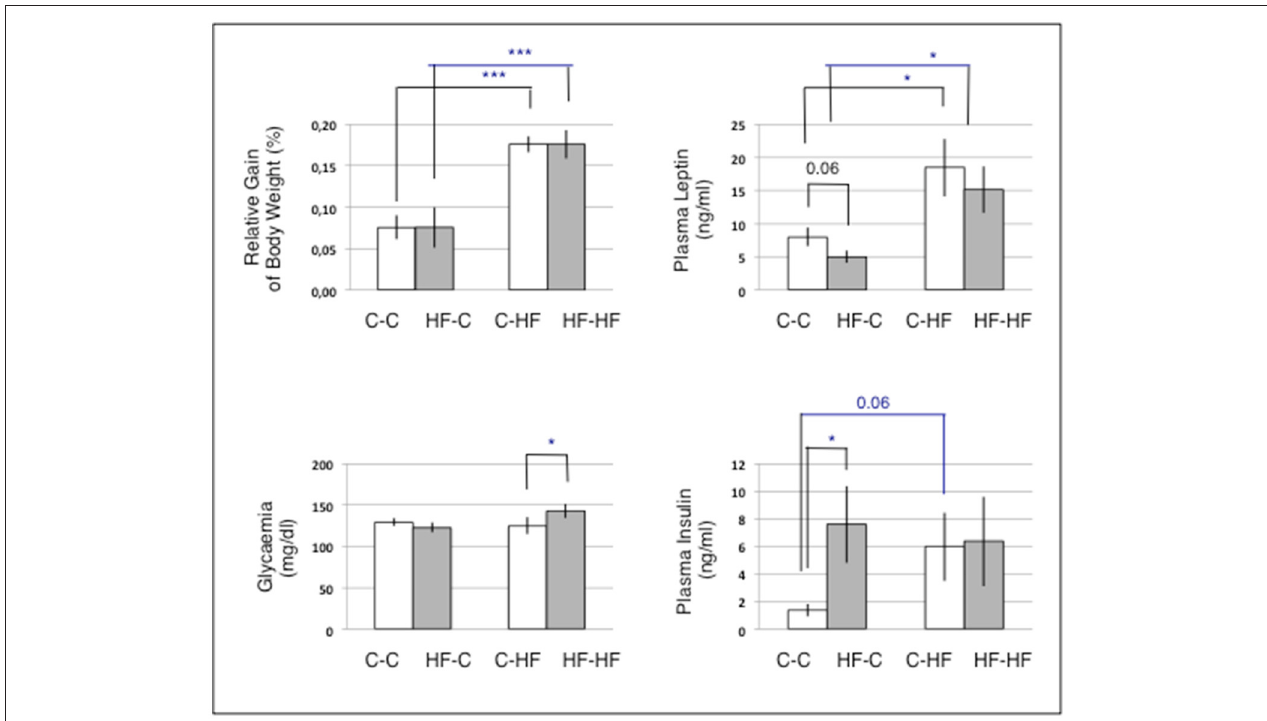
FIGURE 3 | Body weight gains and plasma parameters. For each animal, the gain of body weight was calculated relatively to the body weight at the age of 4.5 months at which animals had been either maintained on the C-diet or shifted to the HF-diet. n = 6/group. Statistics were performed using Mann and Whitney tests. Data are given as mean ± SEM. * p < 0.05; *** p < 0.001. Challenging the perinatal and/or adult diet resulted in differences in circulating nutrients and hormones involved in the lipid and carbohydrate metabolisms.